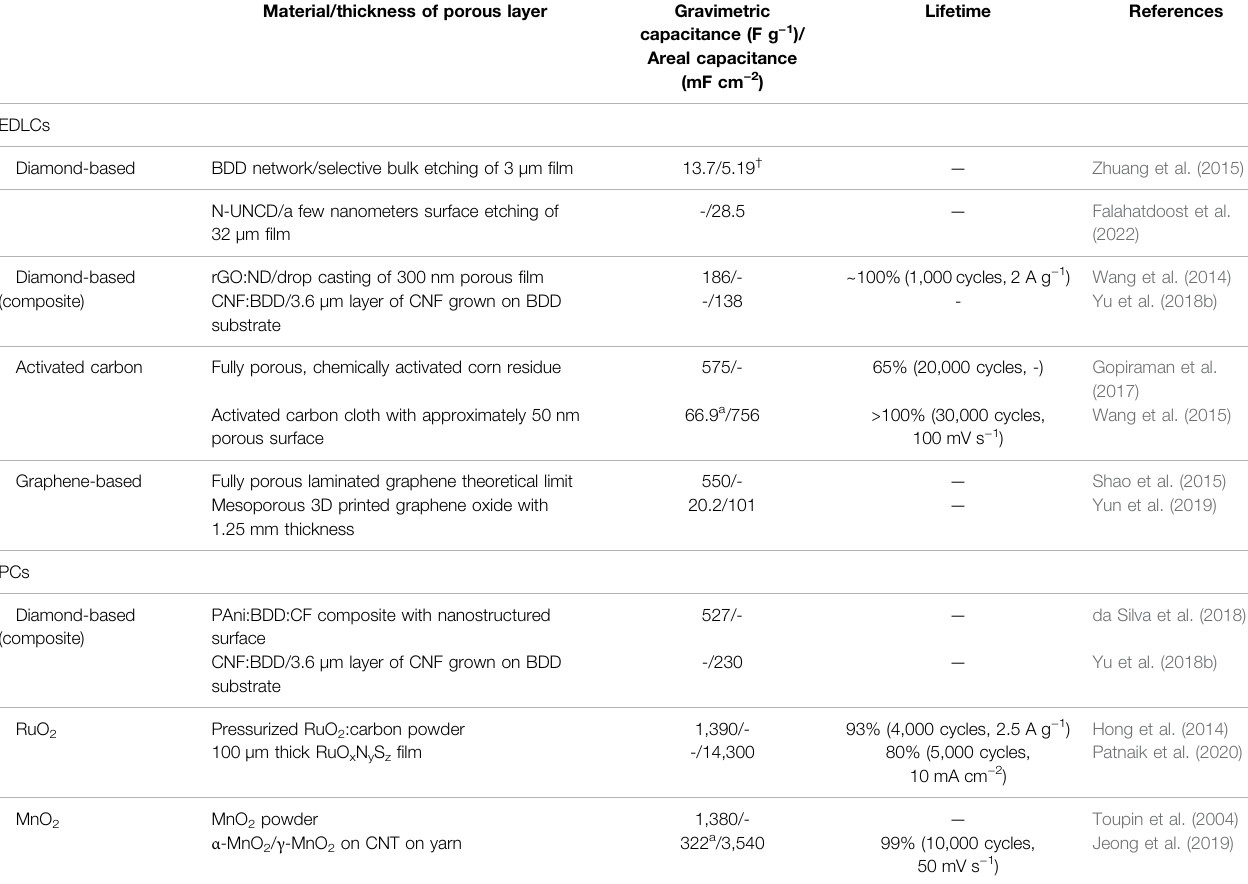
TABLE 1 | A summary of the capacitance and lifetime of aqueous-electrolyte-based capacitors using various materials including